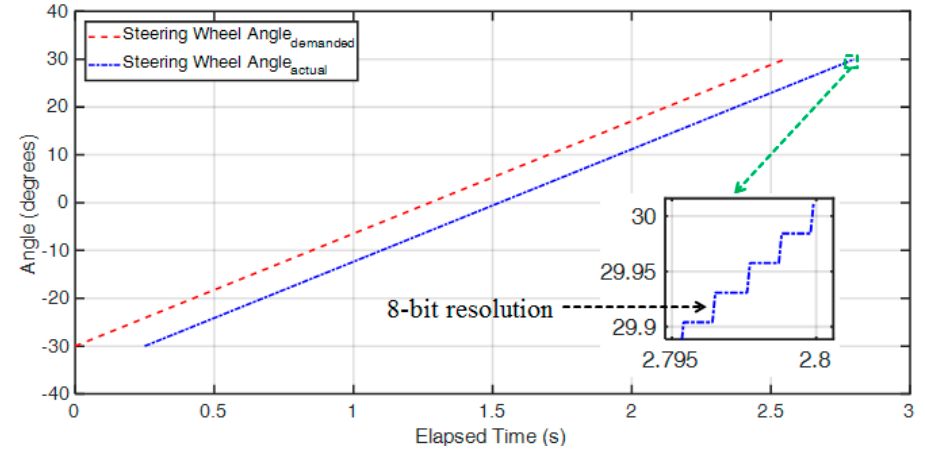
Figure 14. Steering wheel angle vs. time for the drive-by-wire.